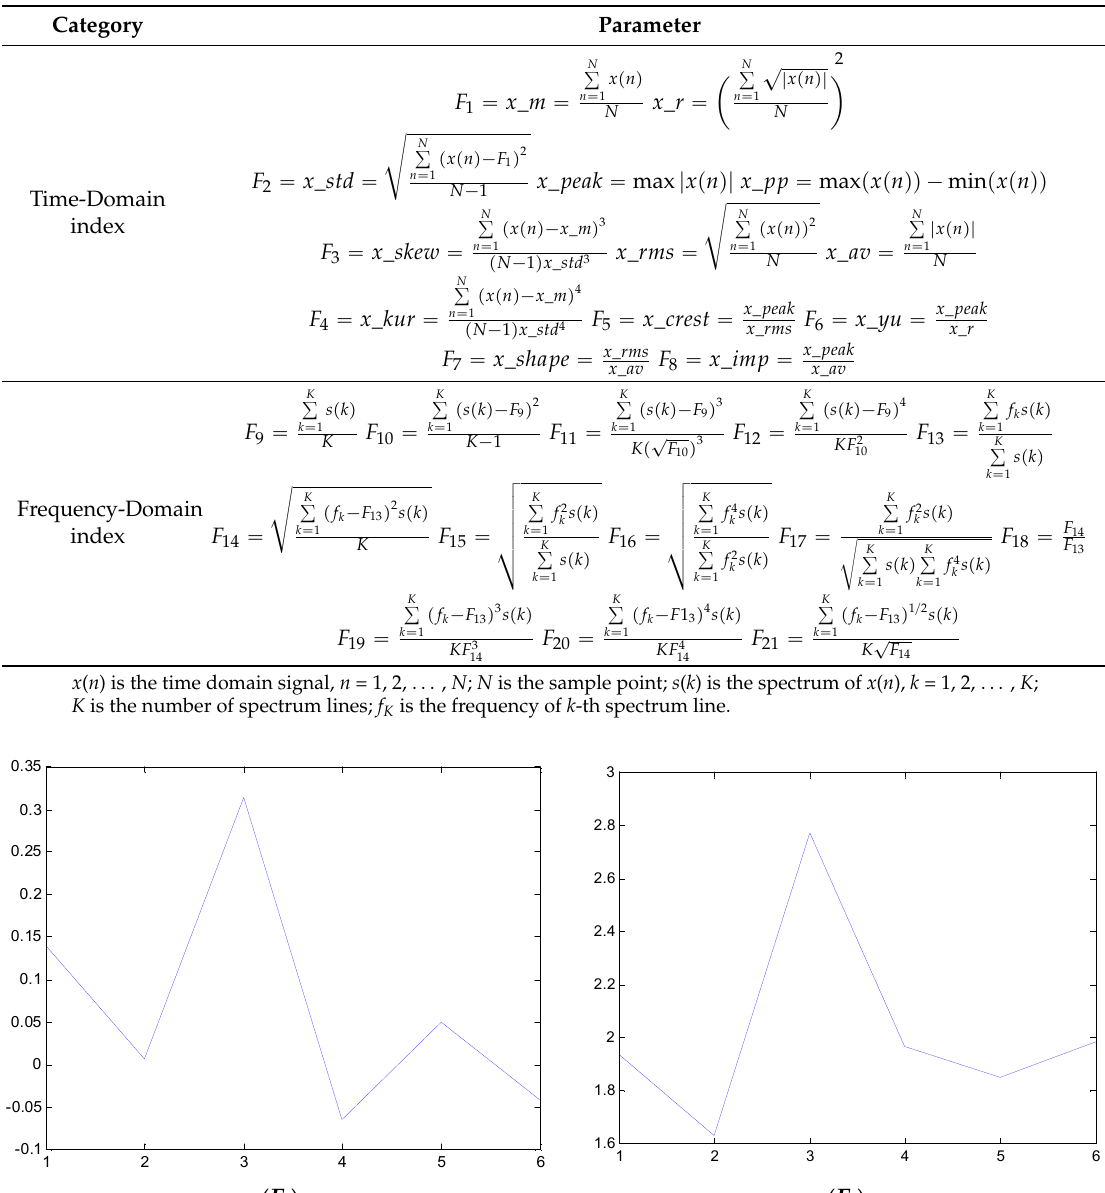
Table 2. The contrastive feature parameters.